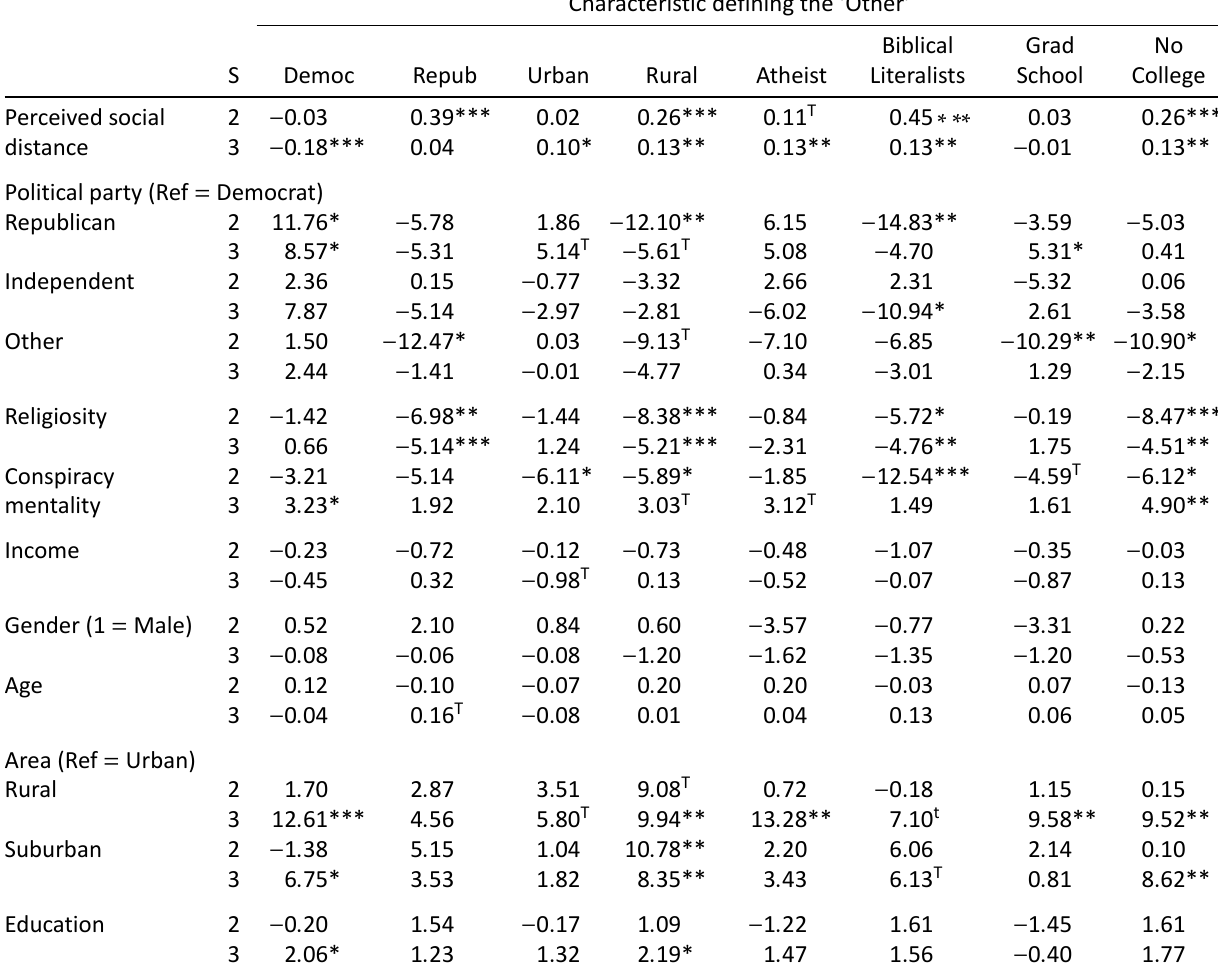
Table 4. GLM analyses for each identity group.